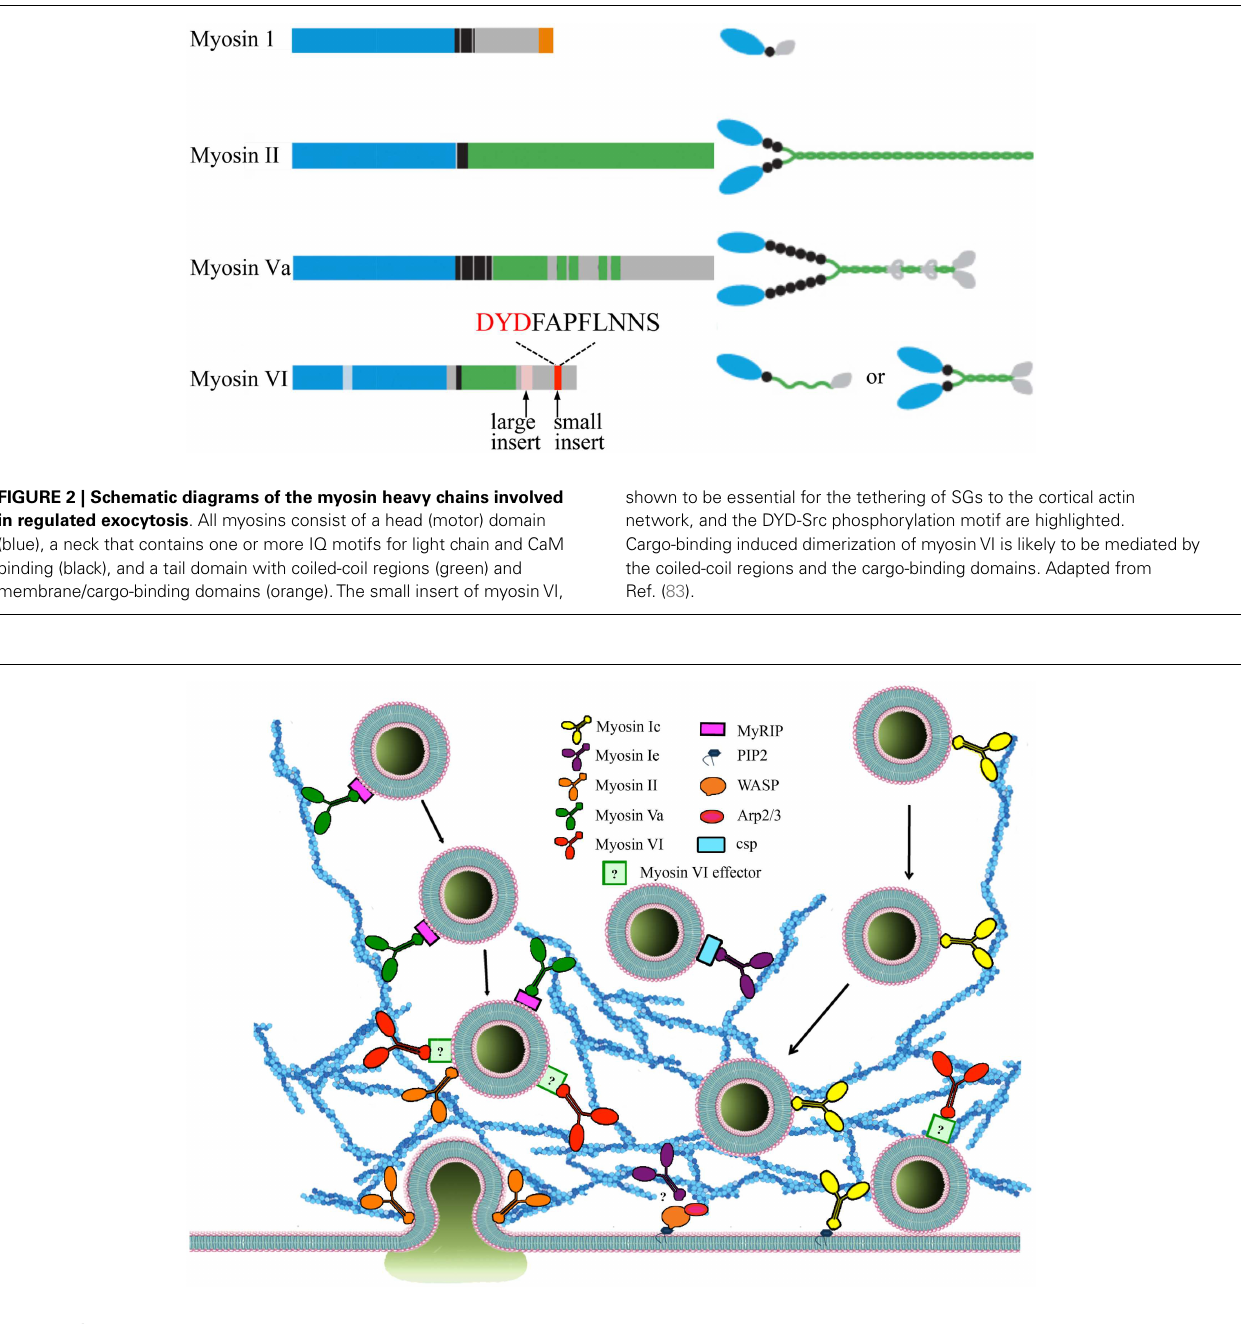
FIGURE 3 |The roles of myosins and accessory proteins involved in regulated exocytosis . Myosins are involved in several steps of regulated exocytosis. Myosin 1C (yellow), myosin 1E (burgundy), myosin II (orange), and myosinVa (green) are involved in secretory vesicle transport. In contrast, myosinVI (red) recruits SGs to the cortical actin network. Myosin 1C interacts with SG through cysteine string proteins and myosinVa binds to MyRIP